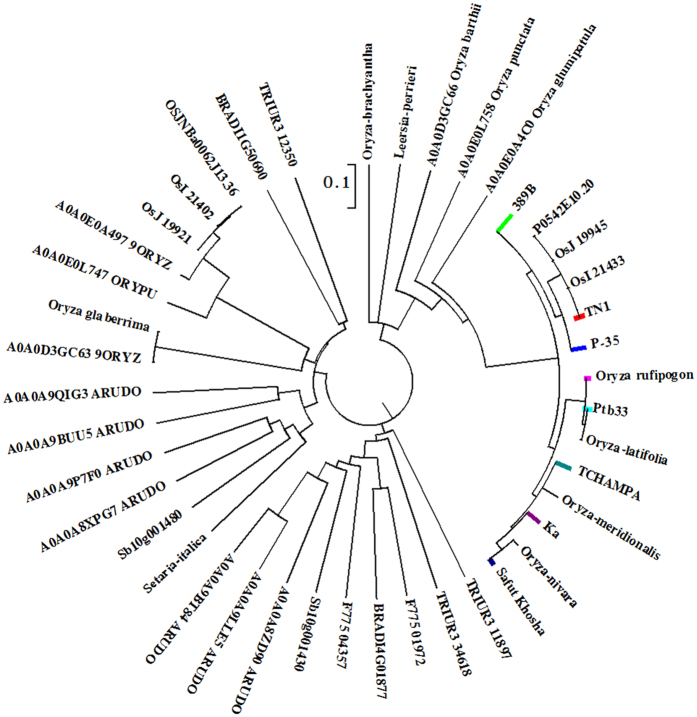
Phylogenetic relationships of Bph32 homologs.Among 123 rice varieties and accessions, Bph32 has eight alleles: the TN1 genotype: bph32 (64), the Ptb33 genotype: Bph32 (21), the 389B genotype: bph32389B (15), the Kasalash genotype: bph32ka (8), the Oryza rufipogon genotype: bph32Or (7), the TCHAMPA genotype: bph32TC (4), the P-35 genotype: bph32p (2) and the Safut Khosha genotype: bph32SK (2). The numbers in brackets represent the numbers of rice varieties and accessions with 100% identity in the Bph32 sequence. Or, Oryza; Sb, sorghum bicolor; ARUDO, Arundo donax; F775, Aegilops tauschii; TRIUA, Triticum urartu; BRADI, Brachypodium distachyon (scale bar: 0.1 amino acid substitutions per site).